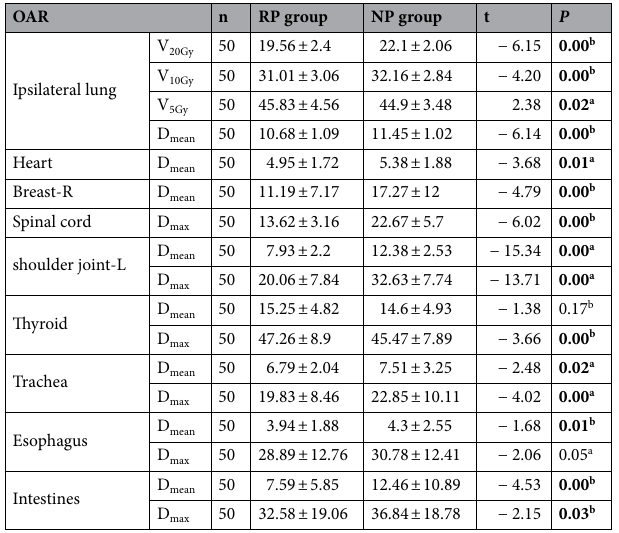
Table 2. Dosimetry comparison for the OAR of RP group and NP group (mean ± SD) (cGy). *a = Paired t test, *b = Nonparametric Wilcoxon test, P < 0.05. Bold values indicates that the difference is statistically significant ( P <0.05)